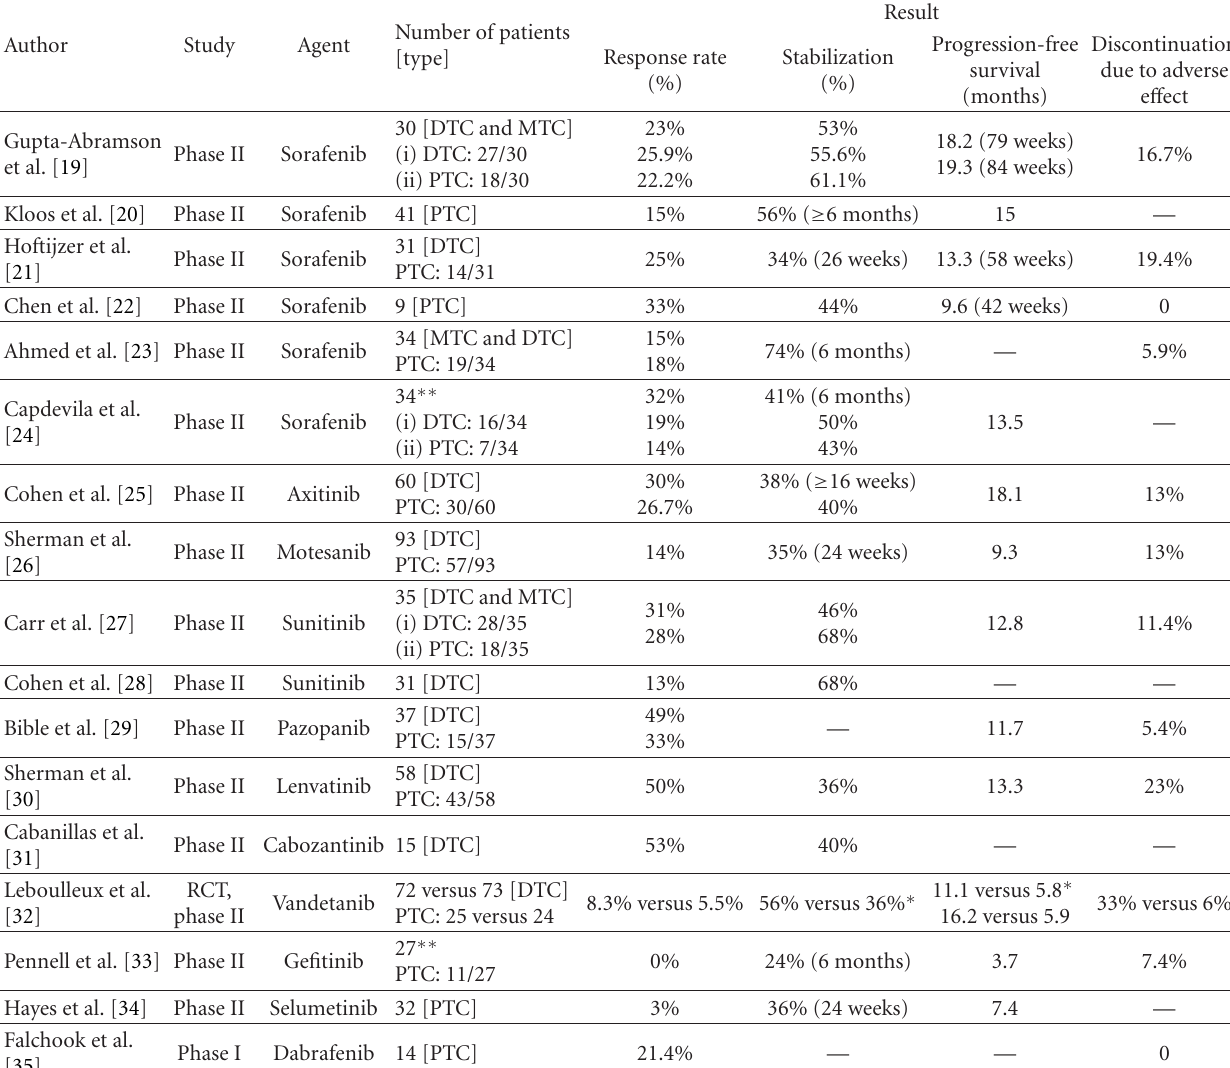
Table 2: Study on target therapy in radioiodine-refractory papillary thyroid